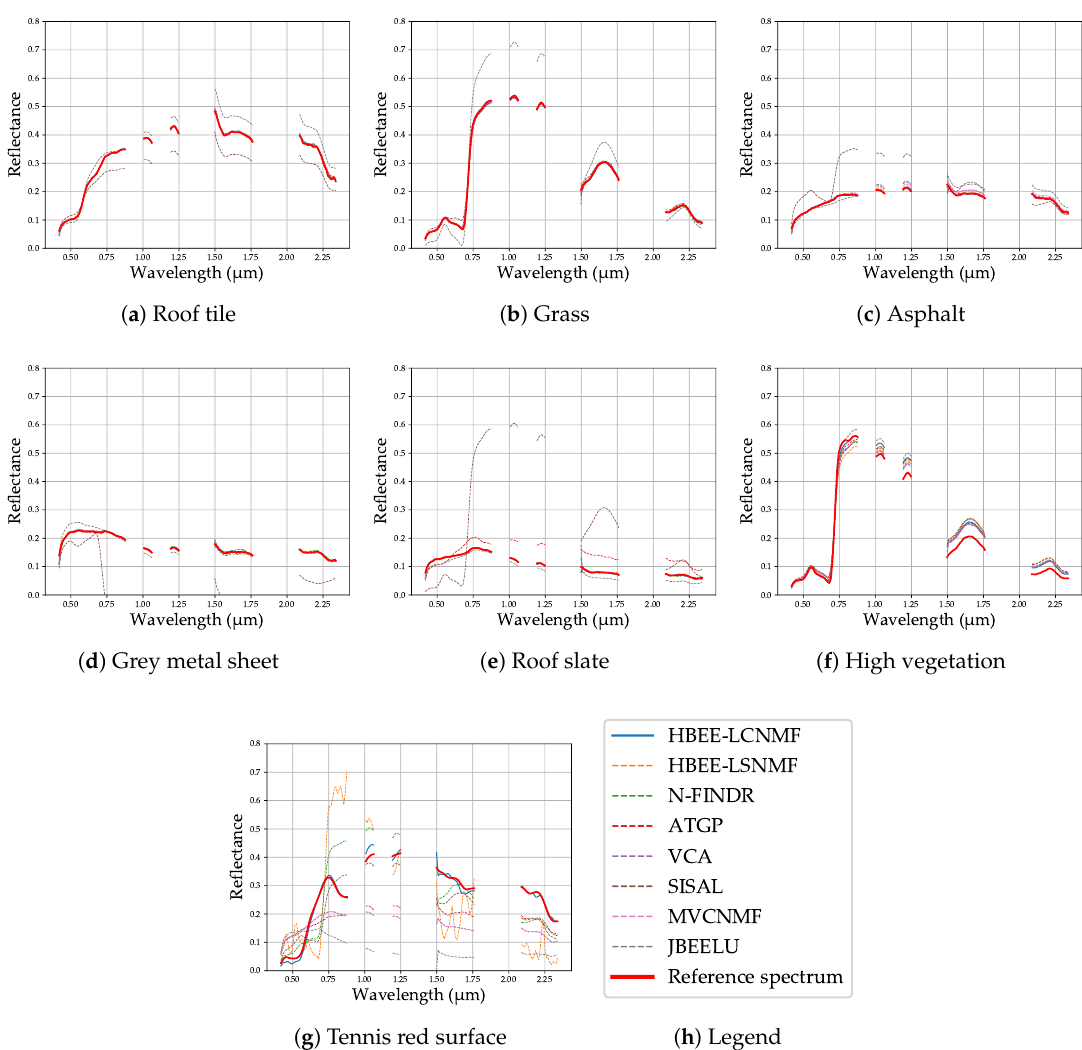
Figure 10. Estimated endmembers compared to their corresponding references. The ( a – e ) plots correspond to materials present in pure pixels and the ( f , g ) plots correspond to highly mixed endmembers. The SAM criterion is used to match the estimated endmembers with the reference